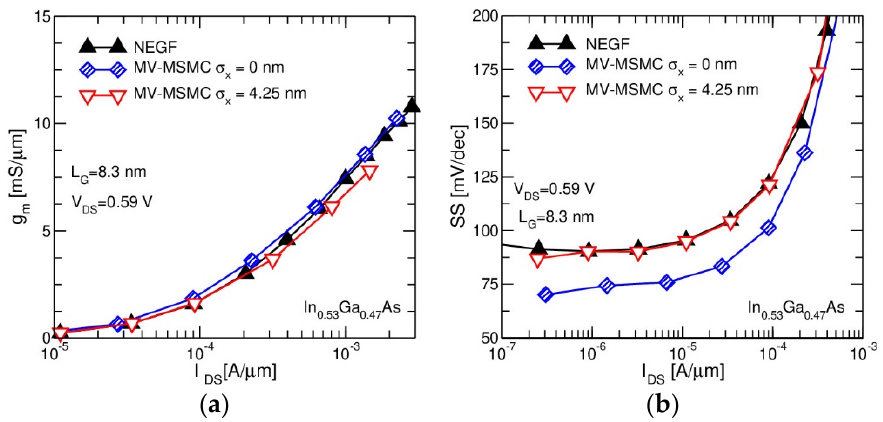
Figure 7. Same as Figure 4 for an InGaAs n-MOSFET with L G of 8.3 nm. V DS is 0.59 V for ( a ) and 50 mV for ( b ).